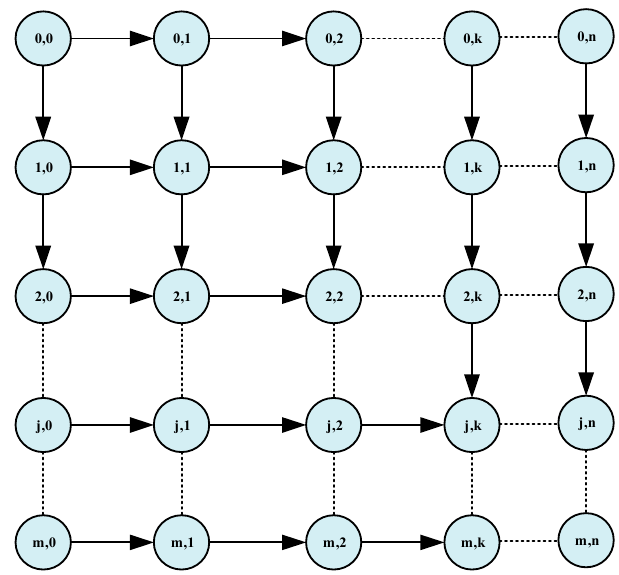
Figure 3. Graph representing the merging sequences.